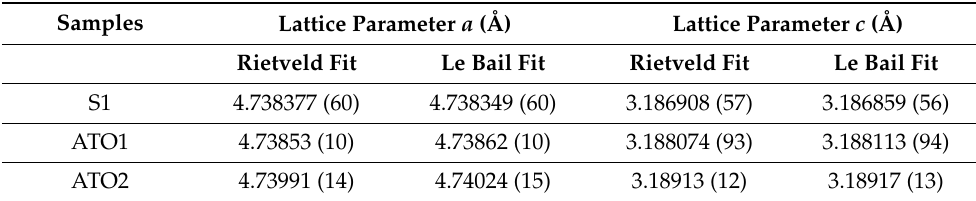
Table 1. Lattice parameters of S1, ATO1, and ATO2 samples estimated by Rietveld and Le Bail approach from XRD data